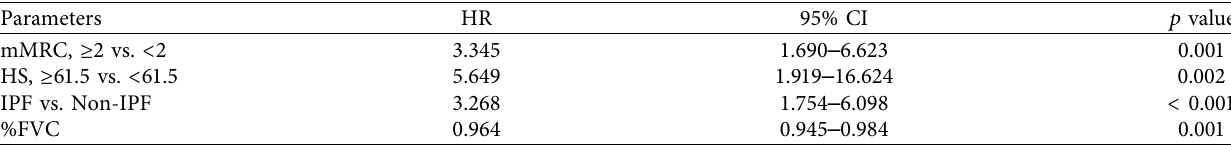
Table 3: Predictive factors of AE in IIPs (multivariate Cox proportional hazard regression